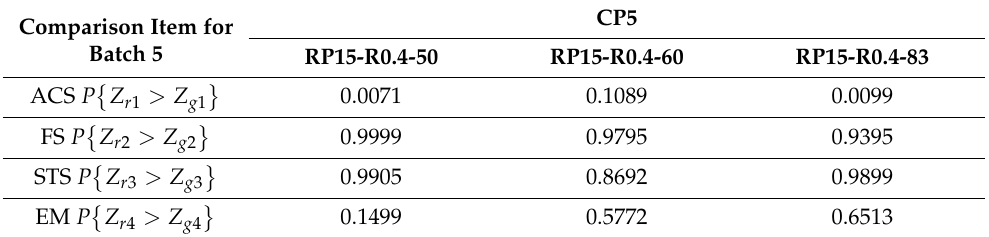
Table 11. Probability that the CVMC for steel fiber concrete is greater that of concrete used for batch 5. Comparison Item for